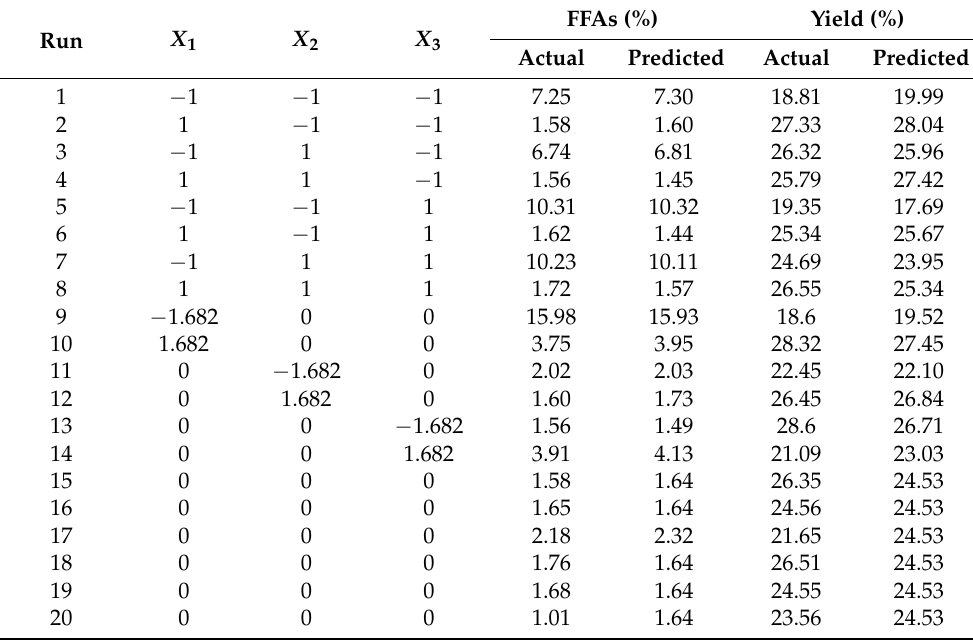
Table 2. Central composite design arrangement and responses.